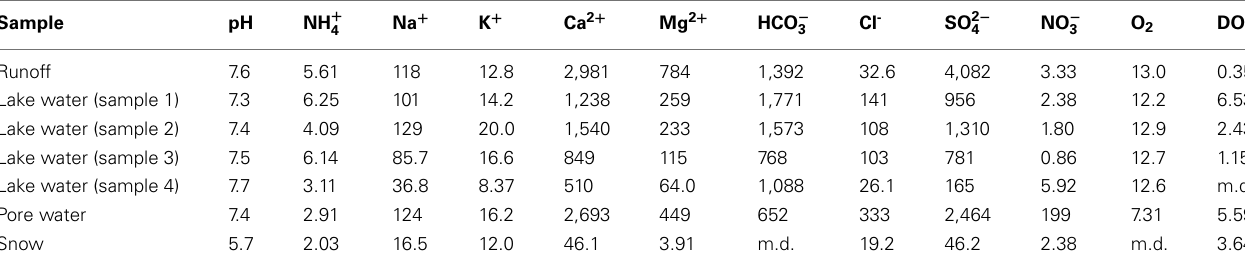
Table 5 | pH and ion concentrations of lake runoff, lake water, pore water, and snow at Mars